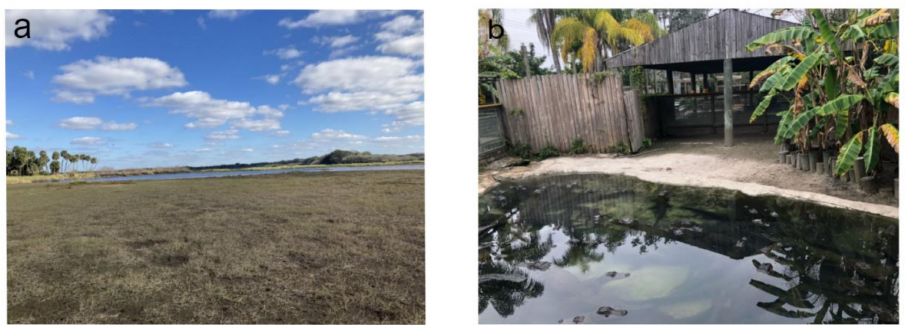
Figure 1. ( a ) The Deep Hole site in the Myakka Wilderness Preserve where wild alligators were observed. The body of water pictured is the sinkhole. ( b ) The captive enclosure at Croc Encounters, a wildlife sanctuary, where captive alligators were observed. The land area is utilized as basking